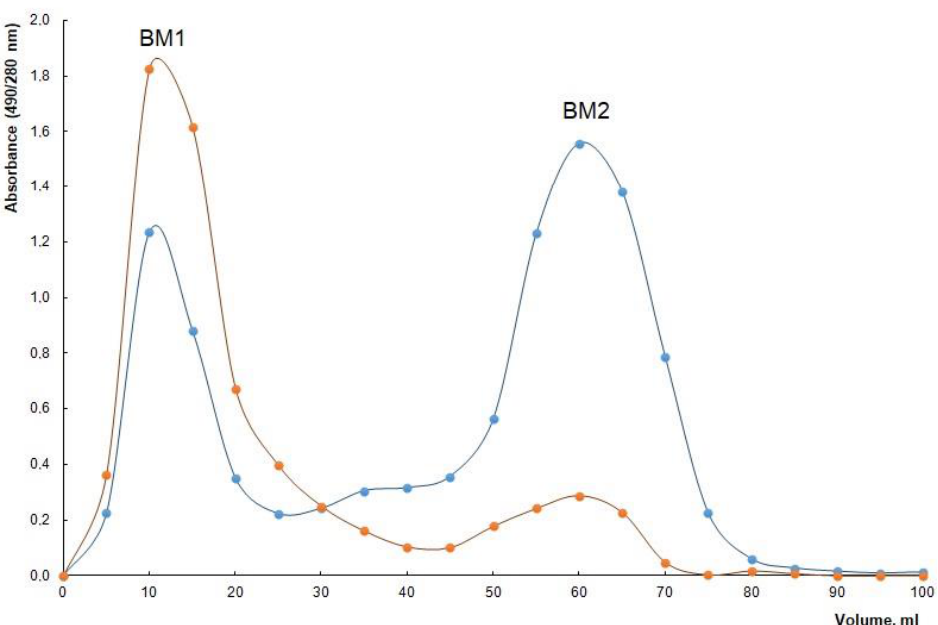
Figure 6. Elution profiles of A. baldaniorum Sp245 biofilm matrix on a Sepharose CL-6B column (showing fractions BM1 and BM2). The carbohydrate content was detected by the phenol–sulfuric acid method (brown line) and the protein content was detected by absorbance at 280 nm (blue line).